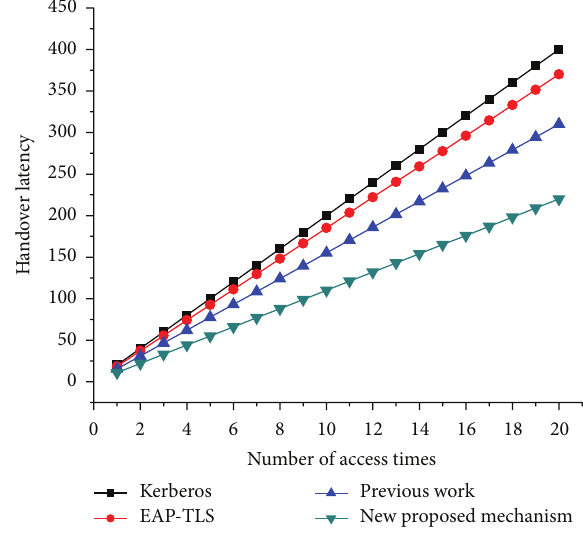
Figure 10: Handover latency versus number of access times.